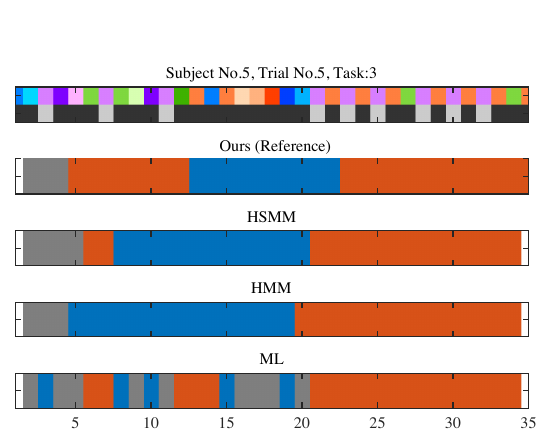
Figure 15 . Example sequences of estimated browsing states. The blue and red intervals correspond to the exploration state and the evaluation state, respectively. The gray interval cor- responds to the start state.